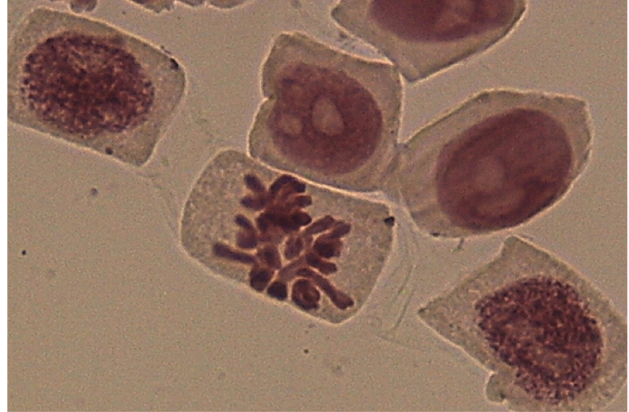
FIGURE 1 - Metaphase with chromosomal breakages.